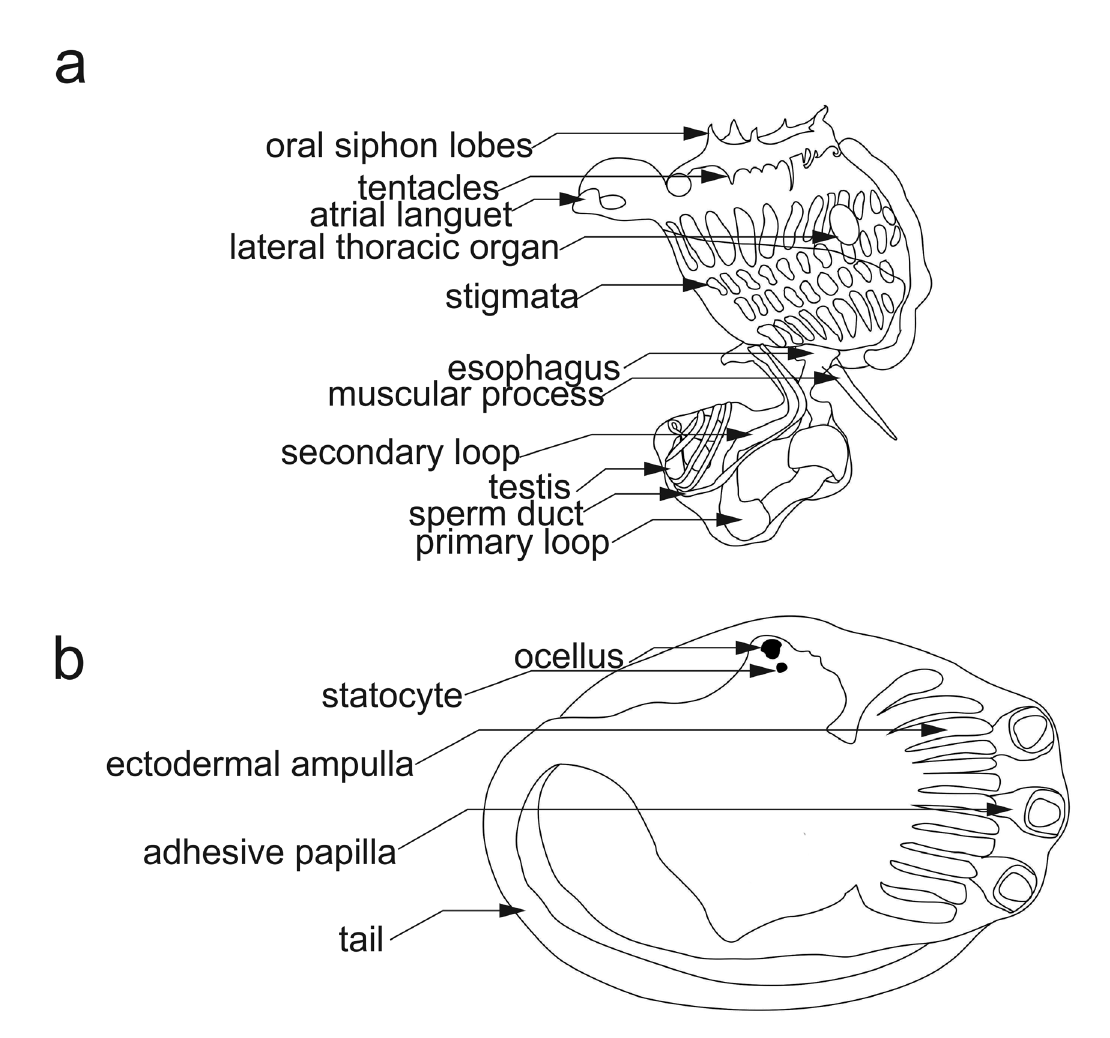
Fig. 1. Morphology of Polysyncraton . a . Zooid characters. b .